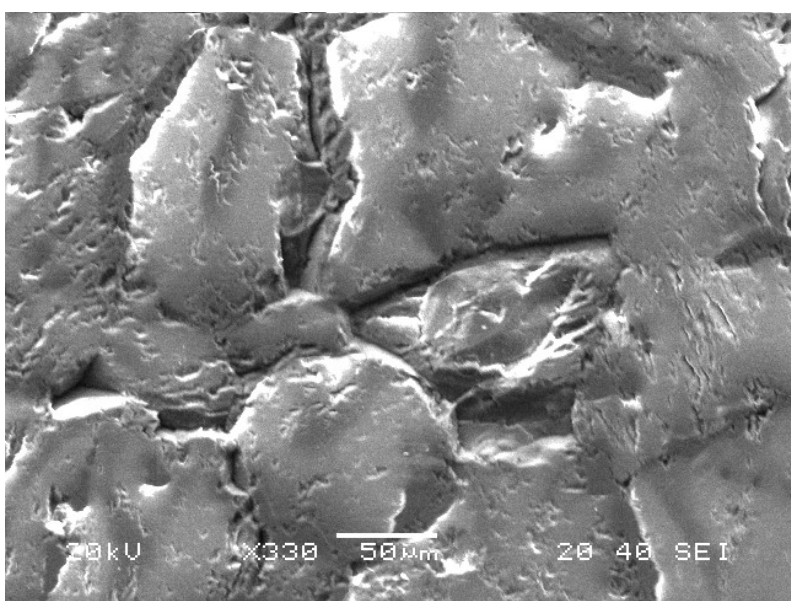
Figure 3. Grain free surfaces of polished specimens.